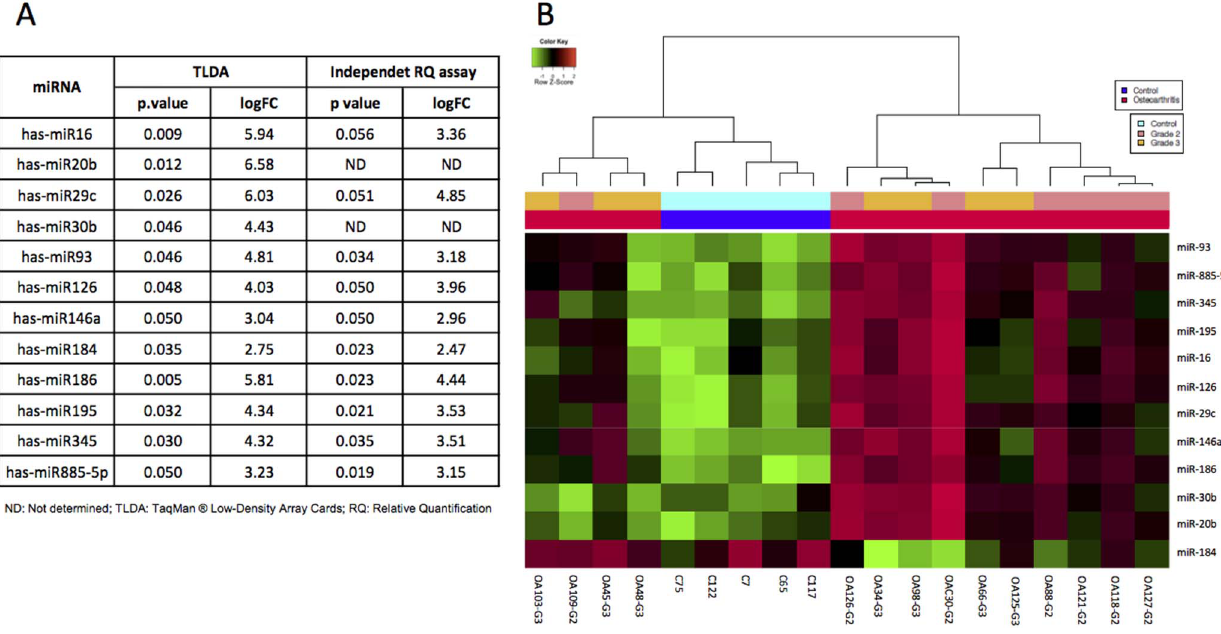
Figure 1. Profiling of plasma MicroRNA (miRNA) levels in patients with Osteoarthritis (OA). (A) Microarray analysis for miRNA levels was performed using RNA extracts from plasma of healthy subjects as control and patients with OA of different OA disease stages; (B) Unsupervised hierarchical clustering of the differentially expressed miRNA. Bright green: down-regulation; black, no change; bright red: up-regulation.